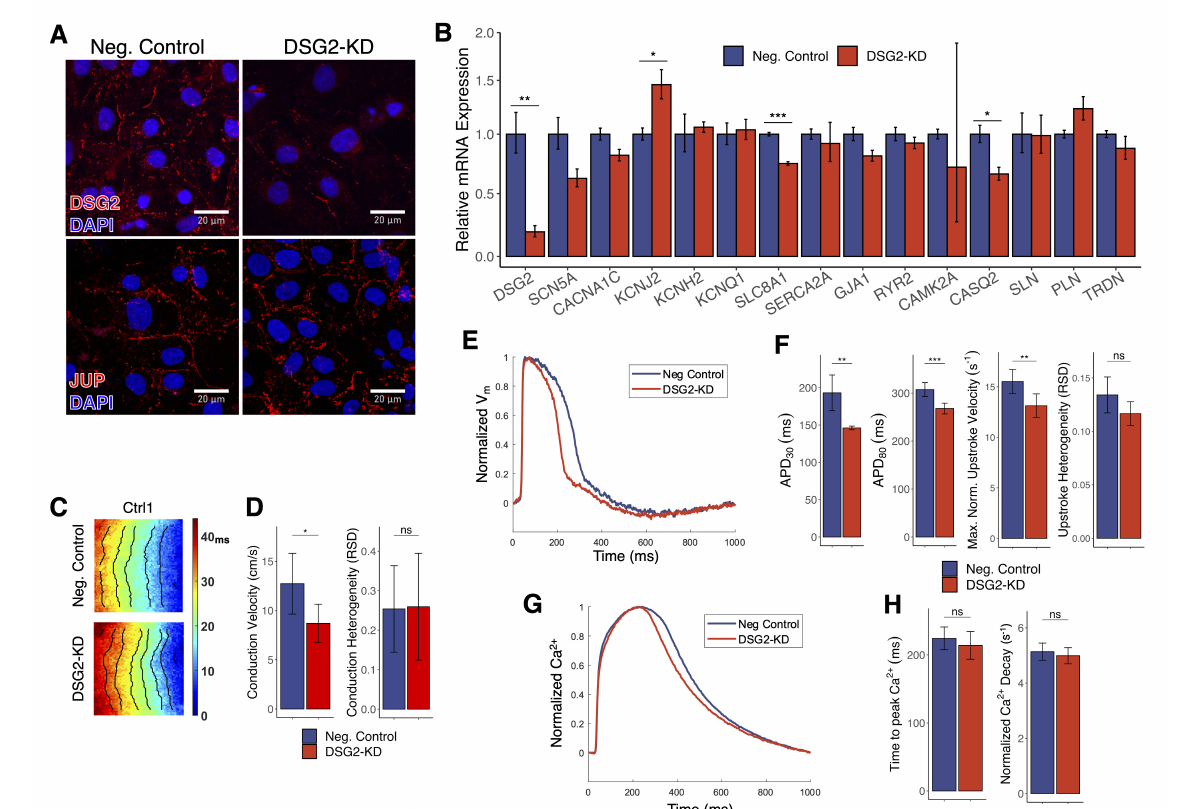
Figure 7. Effects of DSG2 suppression on Ctrl1 hiPSC-CMs. ( A ) Immunostaining for desmoglein-2 and plakoglobin in Ctrl1 hiPSC-CMs treated with anti- DSG2 and negative control siRNA. White scale bars, 20 µ m. ( B ) RT-qPCR measurements of key transcripts in Ctrl1 hiPSC-CMs with and without DSG2 knockdown ( C ) Activation maps with 5 ms isochrones and ( D ) mean conduction velocities and conduction heterogeneity of Ctrl1 hiPSC-CMs with DSG2 knockdown ( E ) Representative V m traces of Ctrl1 hiPSC-CMs with DSG2 knockdown and ( F ) mean action potential characteristics. ( G ) Representative Ca 2+ traces for Ctrl1 hiPSC-CMs with DSG2 knockdown and ( H ) mean Ca 2+ transient characteristics. Neg. Control ( n = 9); DSG2-KD ( n = 8). * p < 0.05, ** p < 0.01, *** p < 0.001, ns = no significant